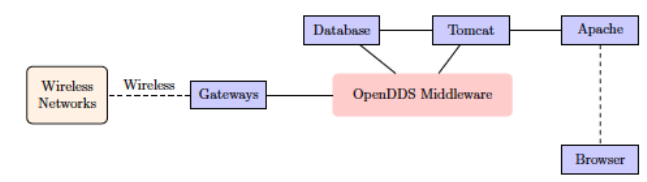
Figure 4. Detailed communication